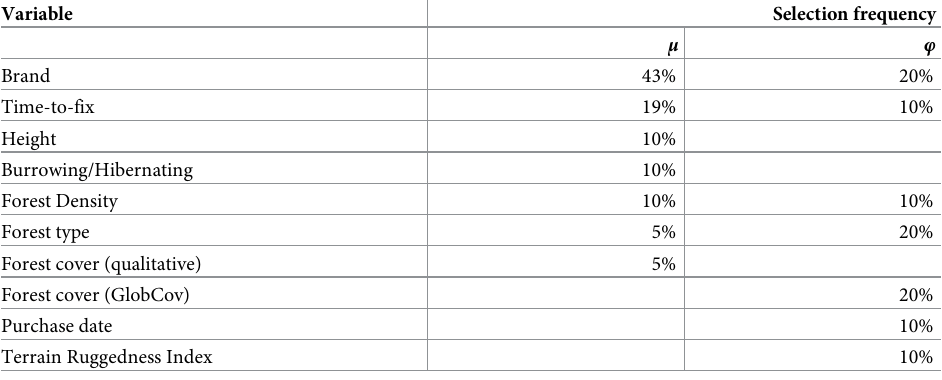
Table 3. Selection frequencies of covariates for both the mean ( μ ) and variability ( φ ) parameters in the boosted beta regression model for the overall fix success